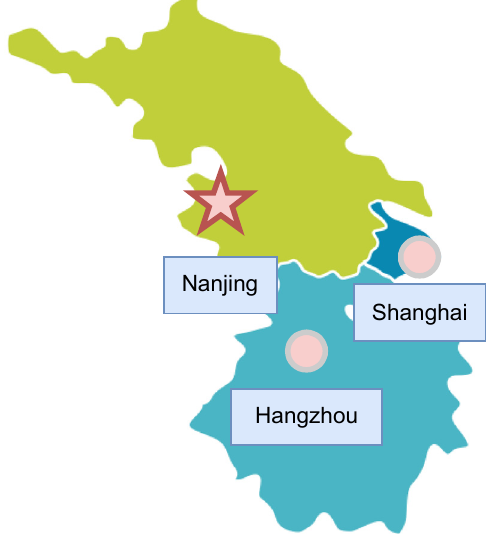
Figure 6. Location of Nanjing.